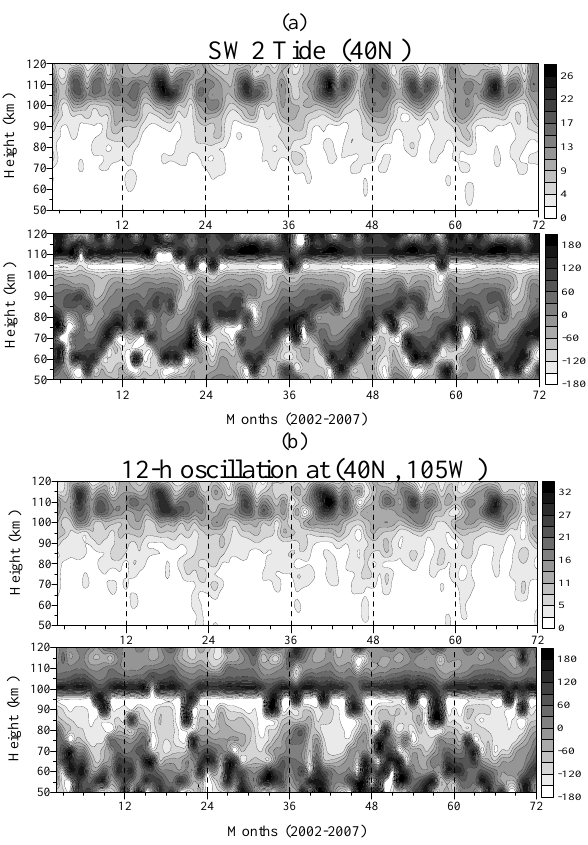
Figure 2 Fig. 2. (a) Altitude-time cross sections of the SABER SW2 tidal amplitudes in Kelvin (upper plot) and phases in degrees (bottom plot) observed at 40 ◦ N during 2002–2007; (b) the same as (a) but for the SABER semidiurnal oscillation (that is a superposition of all semidiurnal tides with zonal wavenumbers up to 4) for a geographic point (40 ◦ N, 105 ◦ W). Figure 3 Fig. 3. (a) Average (2002–2007) vertical/seasonal structures of the SABER SW2 tide; (b) the same as (a) but for the SABER semidi- urnal oscillation at a geographic point (40 ◦ N, 105 ◦